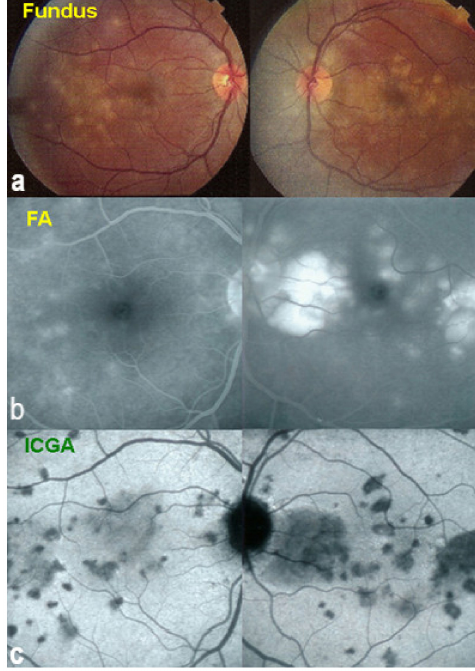
Figure 11. Case of APMPPE/AMIC. Areas of fundus discoloration due to pooling of fluid under the retina ( a ). FA shows pooling of liquid under the retina ( b ). ICGA shows choroidal non-perfusion ( c ).